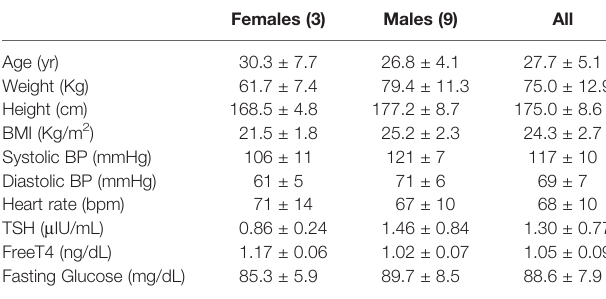
TABLE 1 | Study Participants